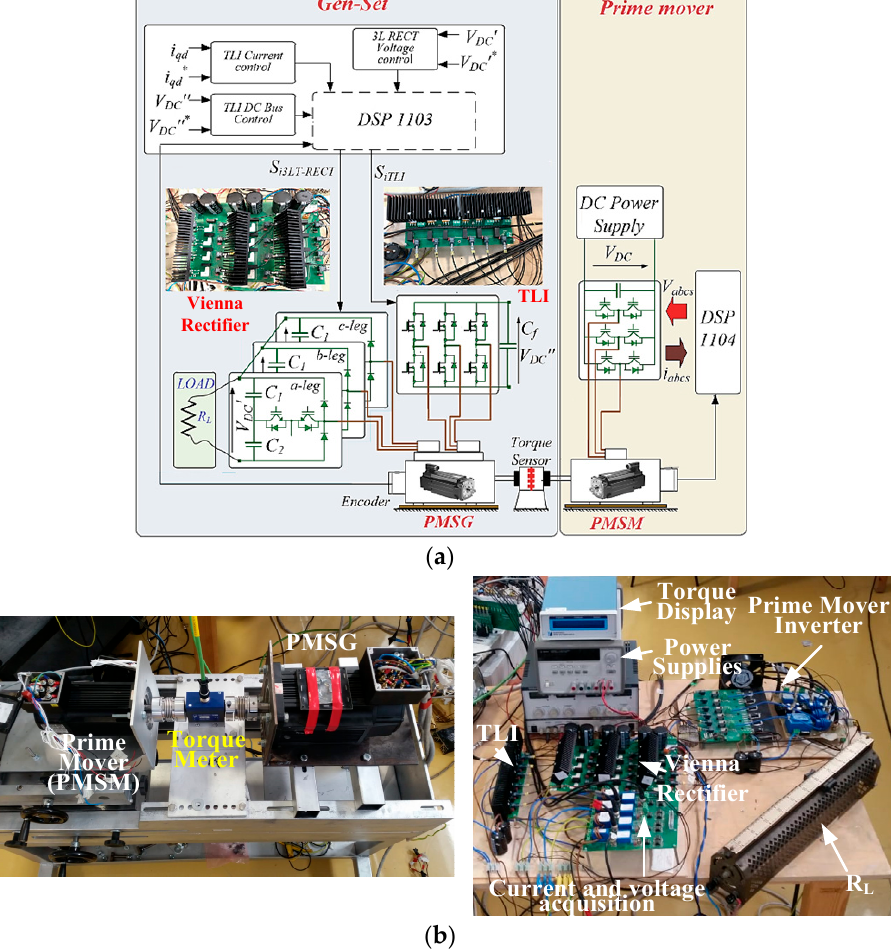
Figure 22. Experimental test bench. ( a ) Block scheme. ( b ) Experimental setup.